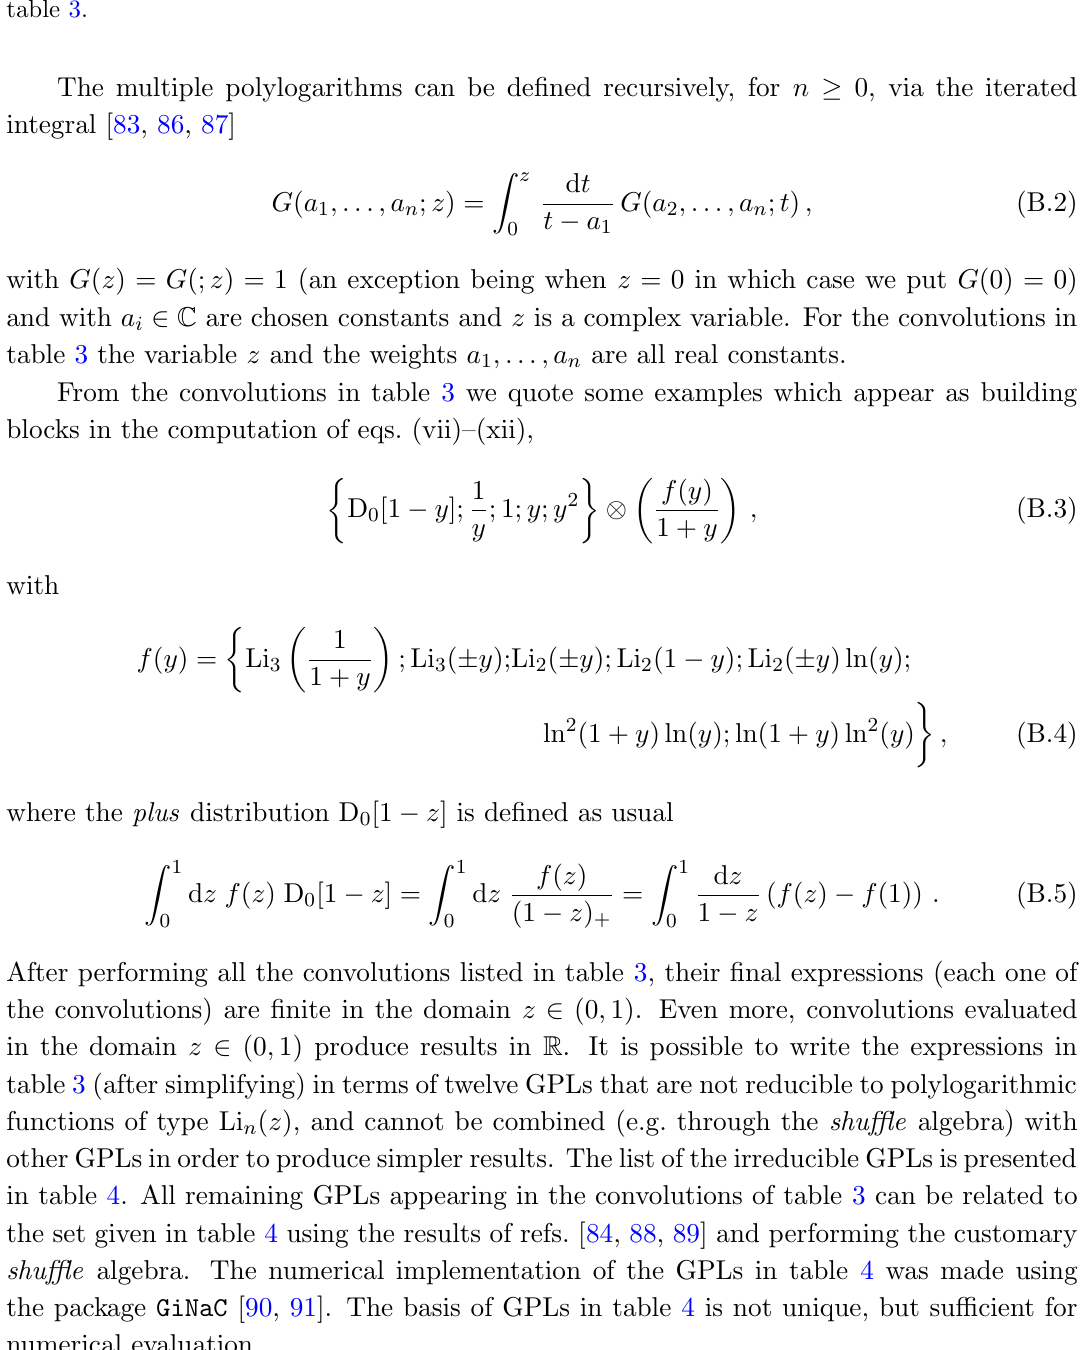
Table 4 . Basis for the GPLs used in the numerical implementation of the convolutions listed in table